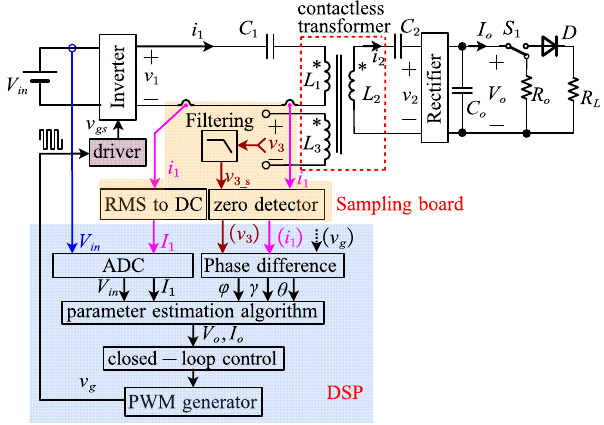
Figure 4. Diagram of IPT system with Tx- side circuit.